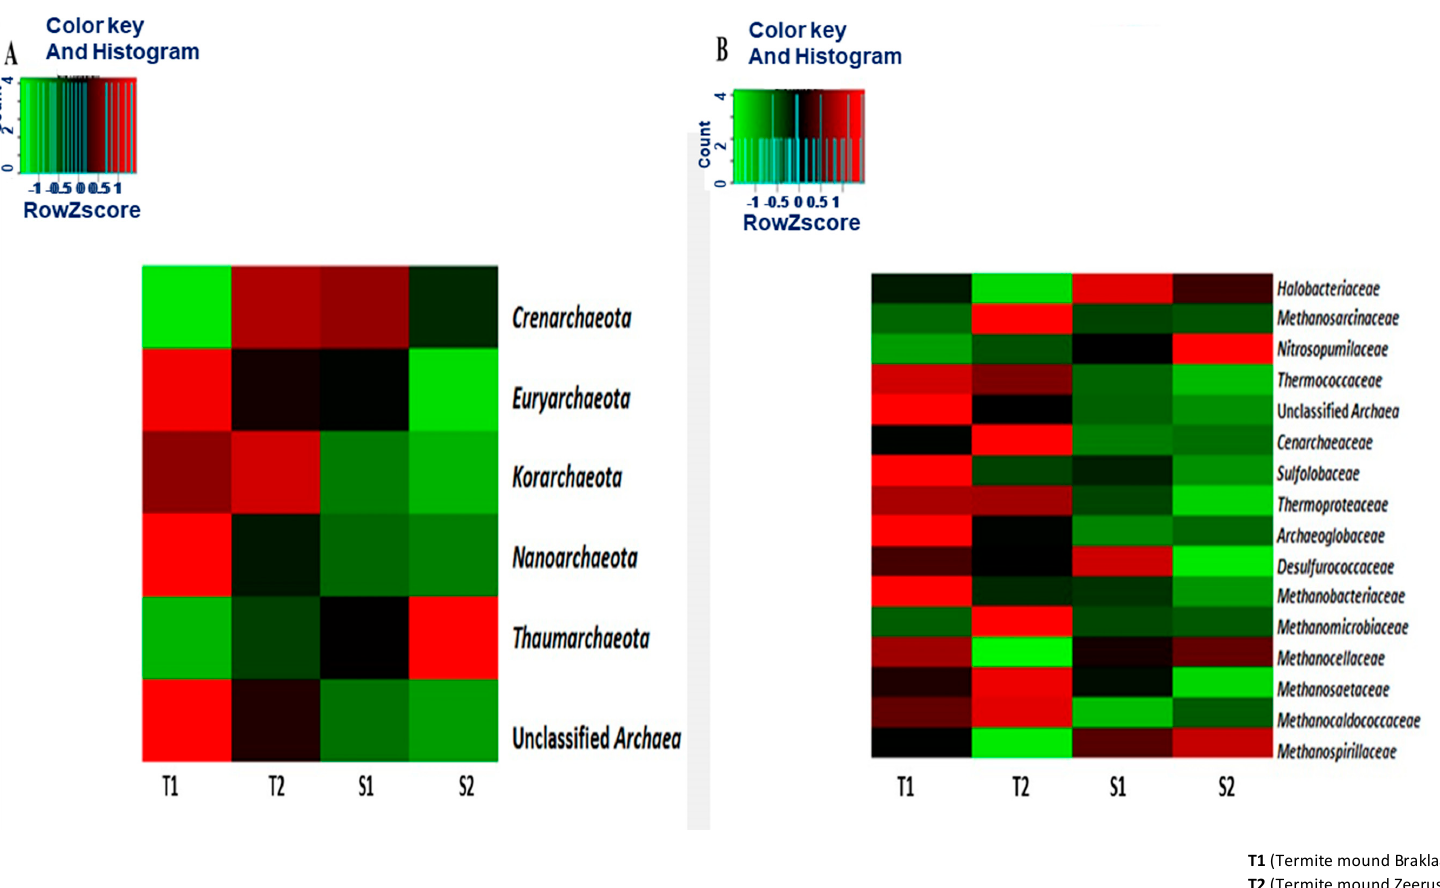
T1 (Termite mound Braklaagte) T2 (Termite mound Zeerust) S1 (Surrounding soil Braklaagte) S2 (Surrounding soil Zeerust)